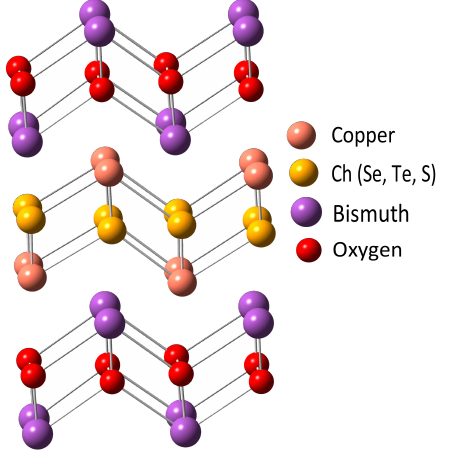
Figure 4: Crystal structure of BiCuOCh (Ch = S, Se, Te).